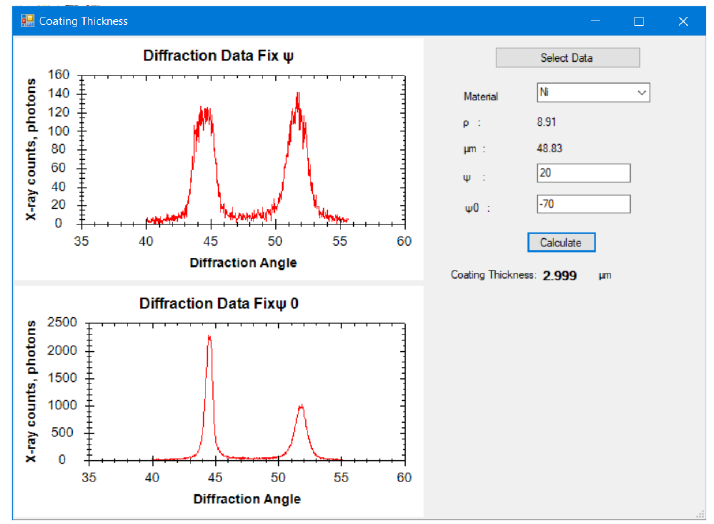
Figure 11. Dialog box for determining the thickness of the nickel-plating layer. Table 7. Thickness for nickel-plating layers with MS, ED, and XRD t echniques (μm) .